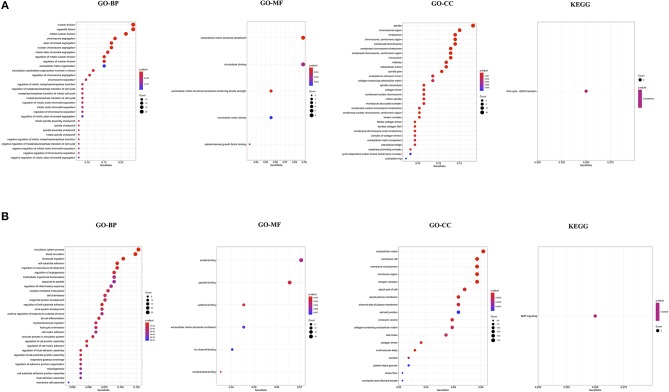
Functional annotation of up-regulated genes in NSCLC (A); and down-regulated genes in NSCLC compared to control (B). GO, Gene Ontology; BP, Biological Processes; MF, Molecular Function; CC, Cell Component; KEGG, Kyoto Encyclopedia of Genes and Genomes.